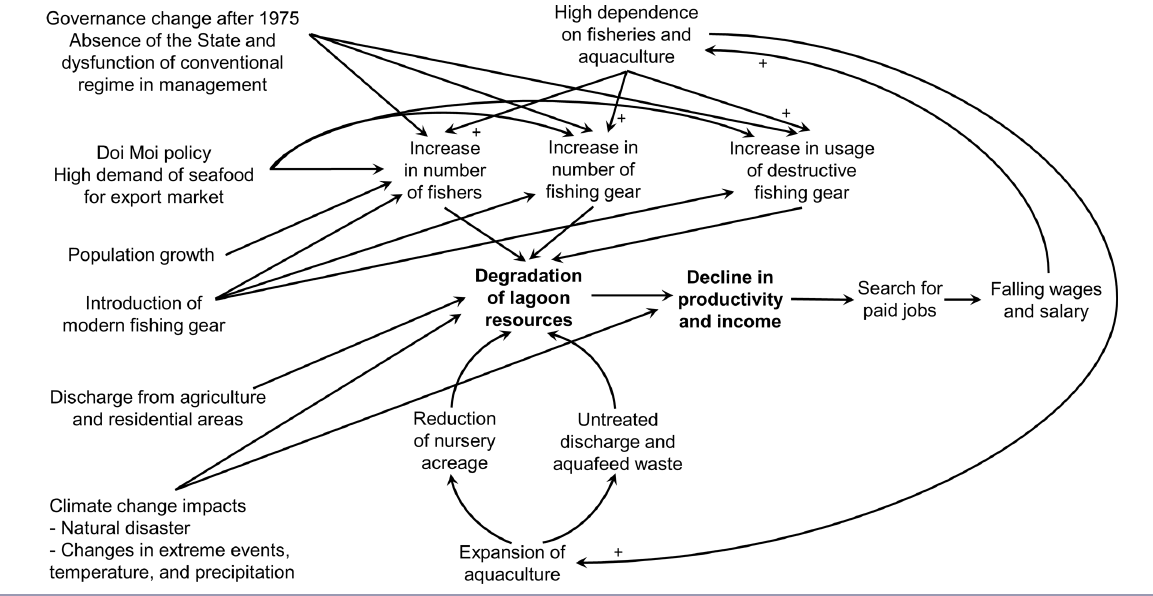
Fig. 2 . Causal loop diagram of the social-ecological trap in the Tam Giang lagoon. Note: "+" indicates reinforcing feedbacks.